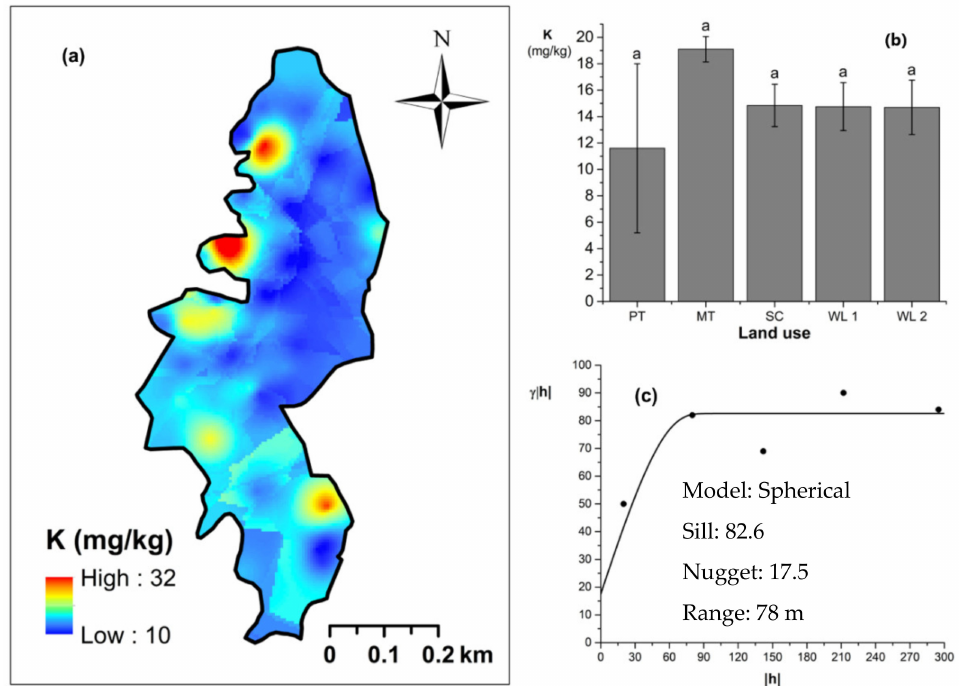
Figure 6. Spatial variability of soil exchangeable K: ( a ) map, ( b ) bar graph among different land uses (see Figure 1, label A for notations) in the Endane Biodiversity Corridor, and ( c ) variogram between lag distance and semivariance. Semivariance function: γ ( h ) = 17.5 + 1.588 h − 8.703 h 3 . Comparisons depicted by the different letters on the bars in subfigure ( b ) indicate significant pair-wise differences.